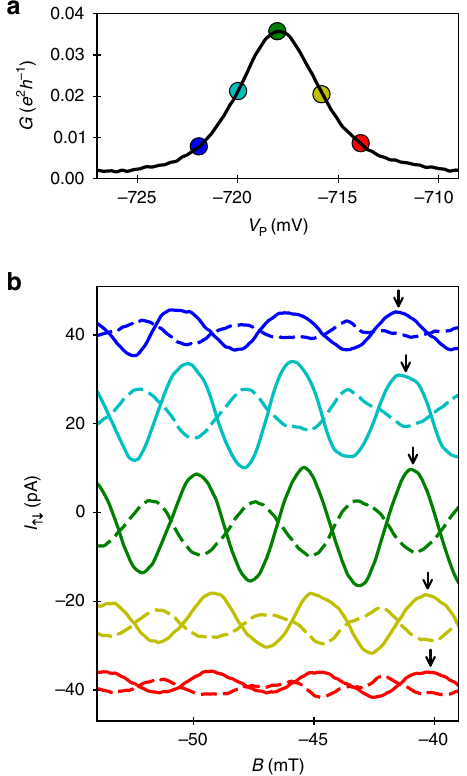
Fig. 2 Anti-phase AB oscillations along a Coulomb blockade peak. a Electrical conductance, G , as the plunger gate voltage, V P , is swept along the resonance. b Excerpts of the currents, I ↑ (solid line) and I ↓ (dashed line), as a function of the magnetic fl ux density, B , for fi ve positions of V P along the resonance. The V P positions of the current traces are indicated via correspondingly coloured data points in a . The arrows indicate the shift of the AB oscillations. For clarity, a continuous background is subtracted and an offset is